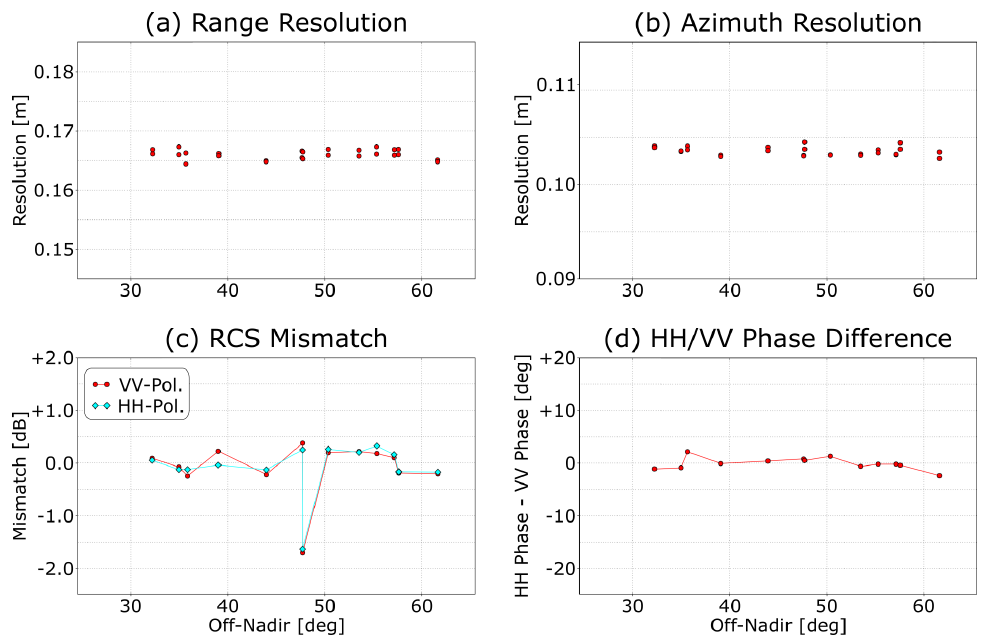
Figure 10. Results of analyzing the response of trihedral reflectors deployed at regular intervals across the imaged swath in focused SAR imagery of the 16DBFTST campaign. Clockwise from the top left: the range ( a ) and azimuth ( b ) resolution achieved; the difference between the expected and the measured target radar cross section ( c ); and HH/VV polarimetric phase imbalance ( d